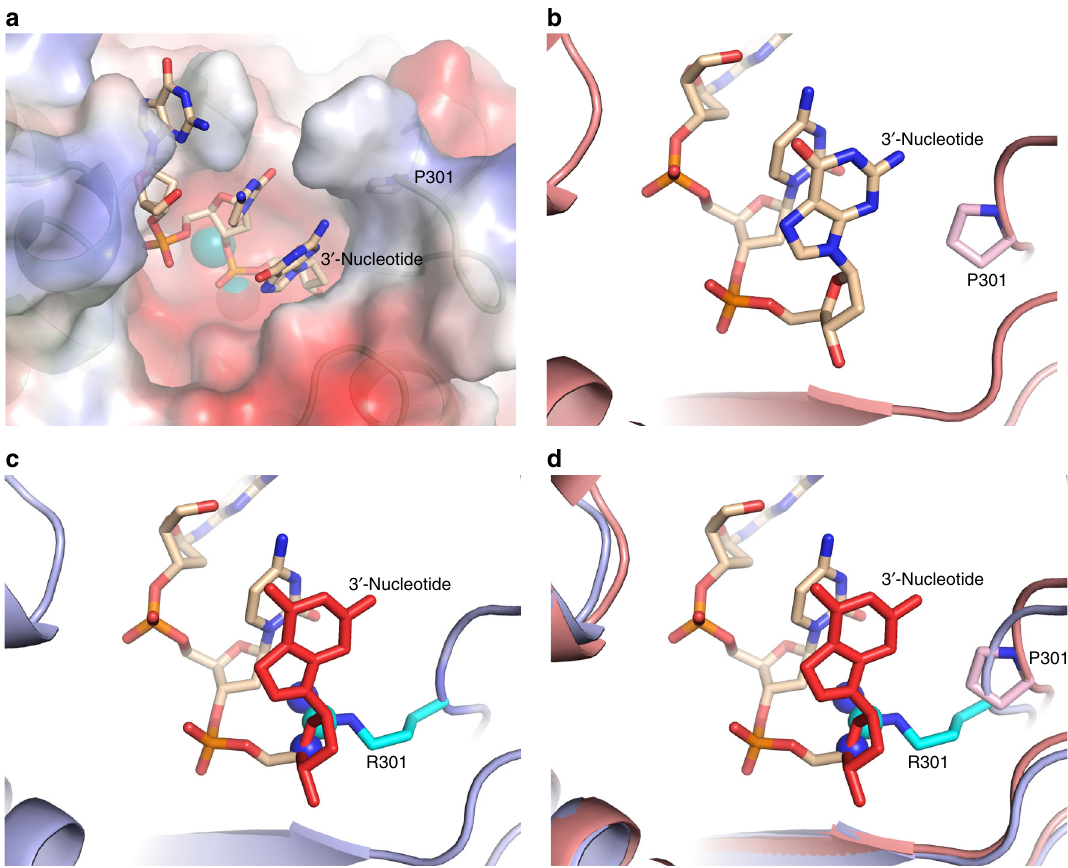
Fig. 4 Modelling DNA into the exonuclease site of Pol2 CORE . a The electrostatic surface view of the wild-type exonuclease domain of Pol2 CORE with the modeled position of single stranded DNA (ssDNA) in the exonuclease active site. A representative structure of the ssDNA from our molecular dynamics simulations is shown as sticks (wheat color). b A representative structure of DNA in the wild-type exonuclease domain of Pol2 CORE from the molecular dynamics simulation in cartoon view. The 3´-end of the ssDNA is shown in the front with P301 (in light pink) in the exo-loop on the right hand side. c The crystal structure of P301R overlayed with the ssDNA from ( b ). The terminal nucleotide (in red) occupies the same space as R301 (the atoms in the guanidine group shown as spheres). d The crystal structure of P301R overlayed with the best representative model from molecular dynamics simulations with wild-type exonuclease domain and ssDNA from ( b ). The terminal nucleotide (in red) occupies the same space as R301 (with the guanidine group shown as